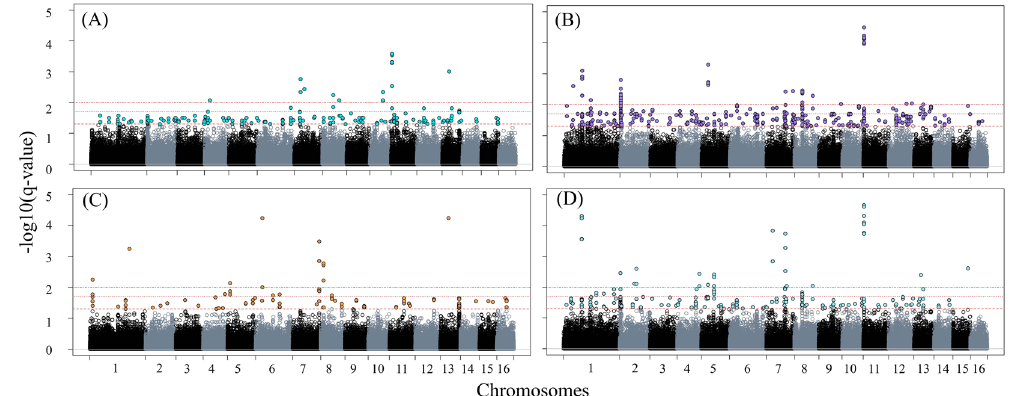
Figure 3. LFMM Manhattan plots. The plots represent the genome-wide distribution of significance values − log10 (q-value) obtained by LFMM for the environmental variables with the strongest associations. ( A )